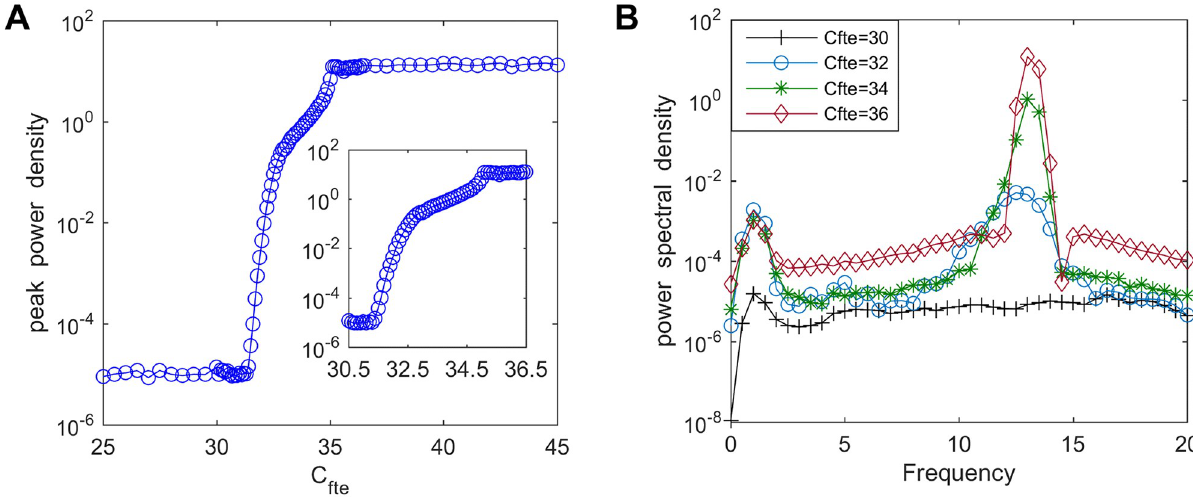
Fig 2. The peak power density and the corresponding power spectral density for varying values of C fte . (A) The peak power density within the alpha band of the thalamic output. (B) The corresponding power spectral density for different connectivity parameters such as C